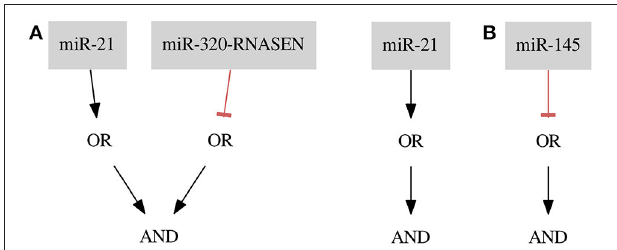
FIGURE 8 | Results for the breast cancer (A) ER + Her − and (B) Cell Line data sets.